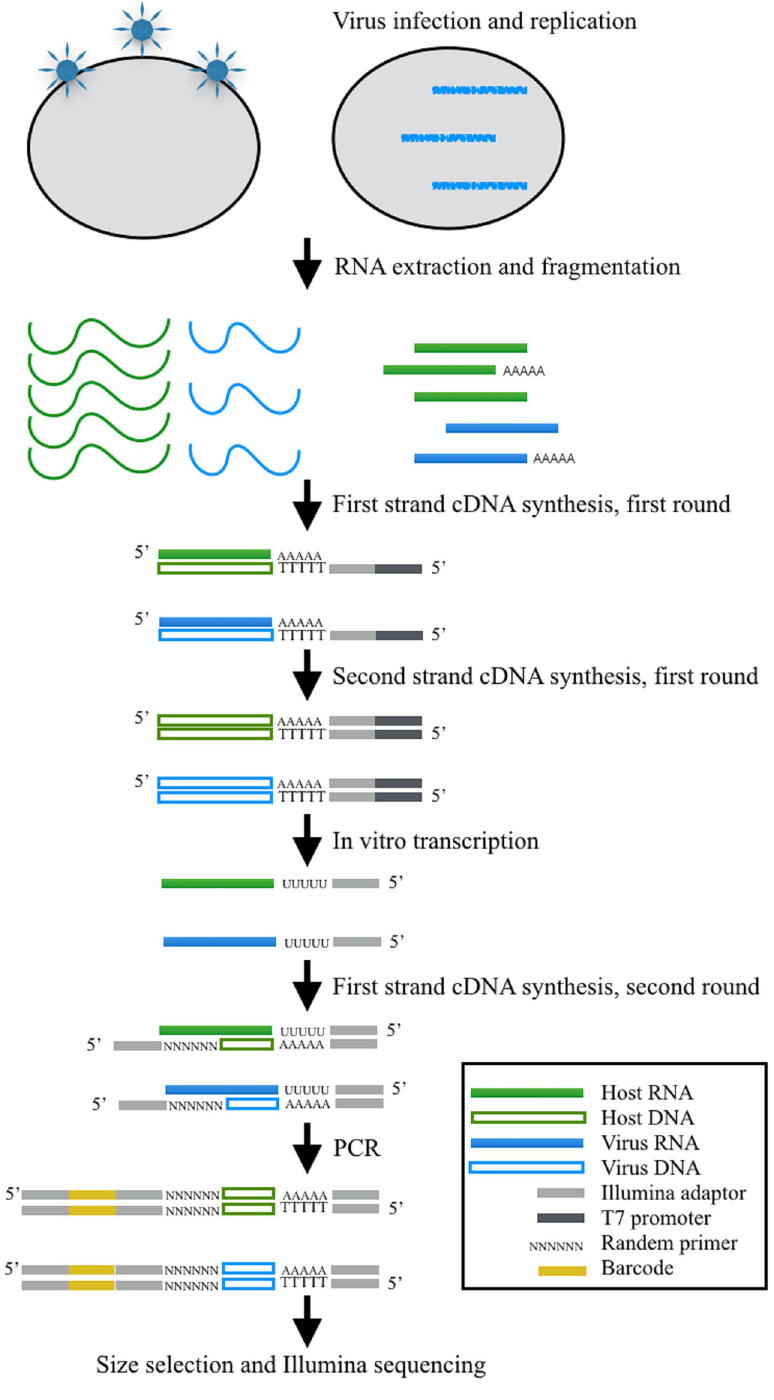
Figure 1. Workflow for 3 ′ end enriched RNA-seq of host and pathogen